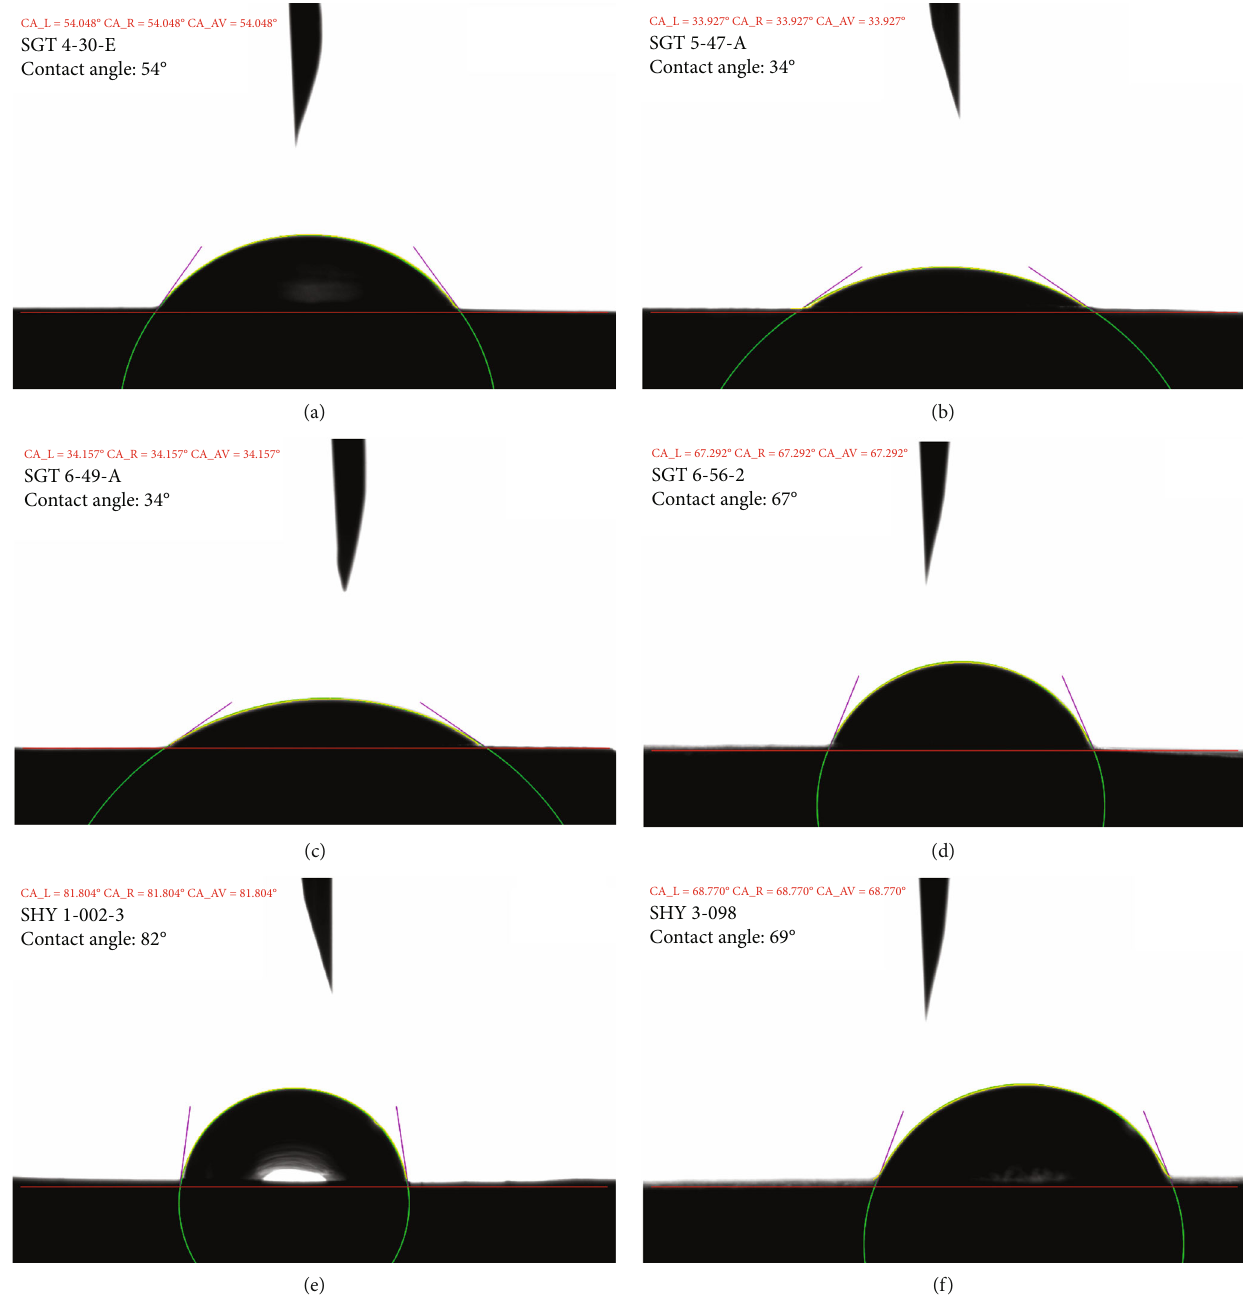
Figure 7: Contact angle (in degrees) measurements (at 30 s after droplet